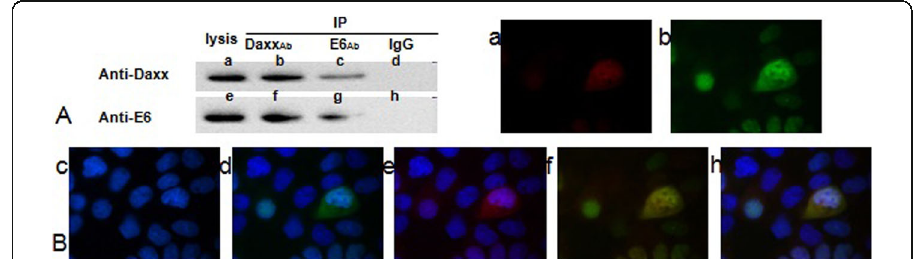
complex pulled down by the IgG antibody with anti-Daxx antibody (negative control of Daxx); (e) the cell lytic supernatant with anti-E6 antibody (positive control of HPV16 E6); (f) the complex pulled down by the anti-Daxx antibody with anti-E6 antibody; (g) the complex pulled down by the anti-E6 antibody with anti- E6 antibody; (h) the complex pulled down by the IgG antibody with anti-E6 antibody (negative control of HPV16 E6). B Localization of HPV16 E6 and Daxx via indirect immunofluorescence. (a) C33A cells with mouse anti-E6 antibodies visualized with TRITC-conjugated goat anti-mouse IgG (red); (b) C33A cells with rabbit anti-Daxx antibodies visualized with FITC -conjugated goat anti-rabbit IgG (green); (c) C33A cells with DNA dye (blue); (d) a and c overlapped; (e) b and c overlapped; (f) a and b overlapped, showing yellow fluorescence; (h) a, b and c